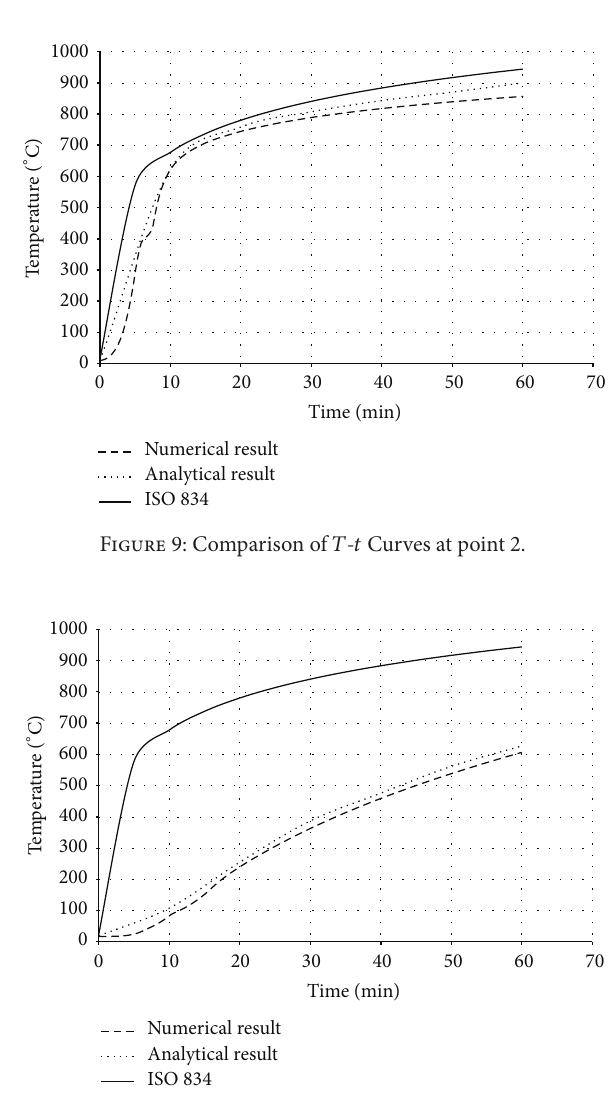
Figure 10: Comparison of 𝑇 - 𝑡 Curves at point